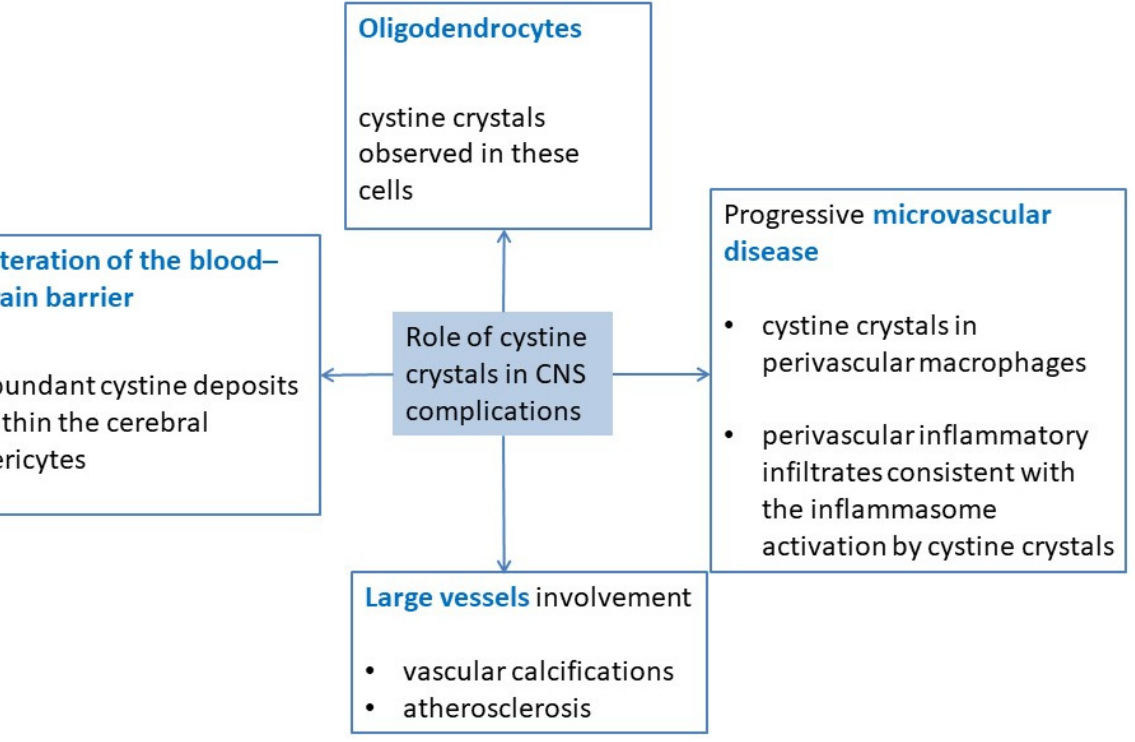
Figure 1. Role of cystine crystals in CNS complications: pathophysiological hypotheses.